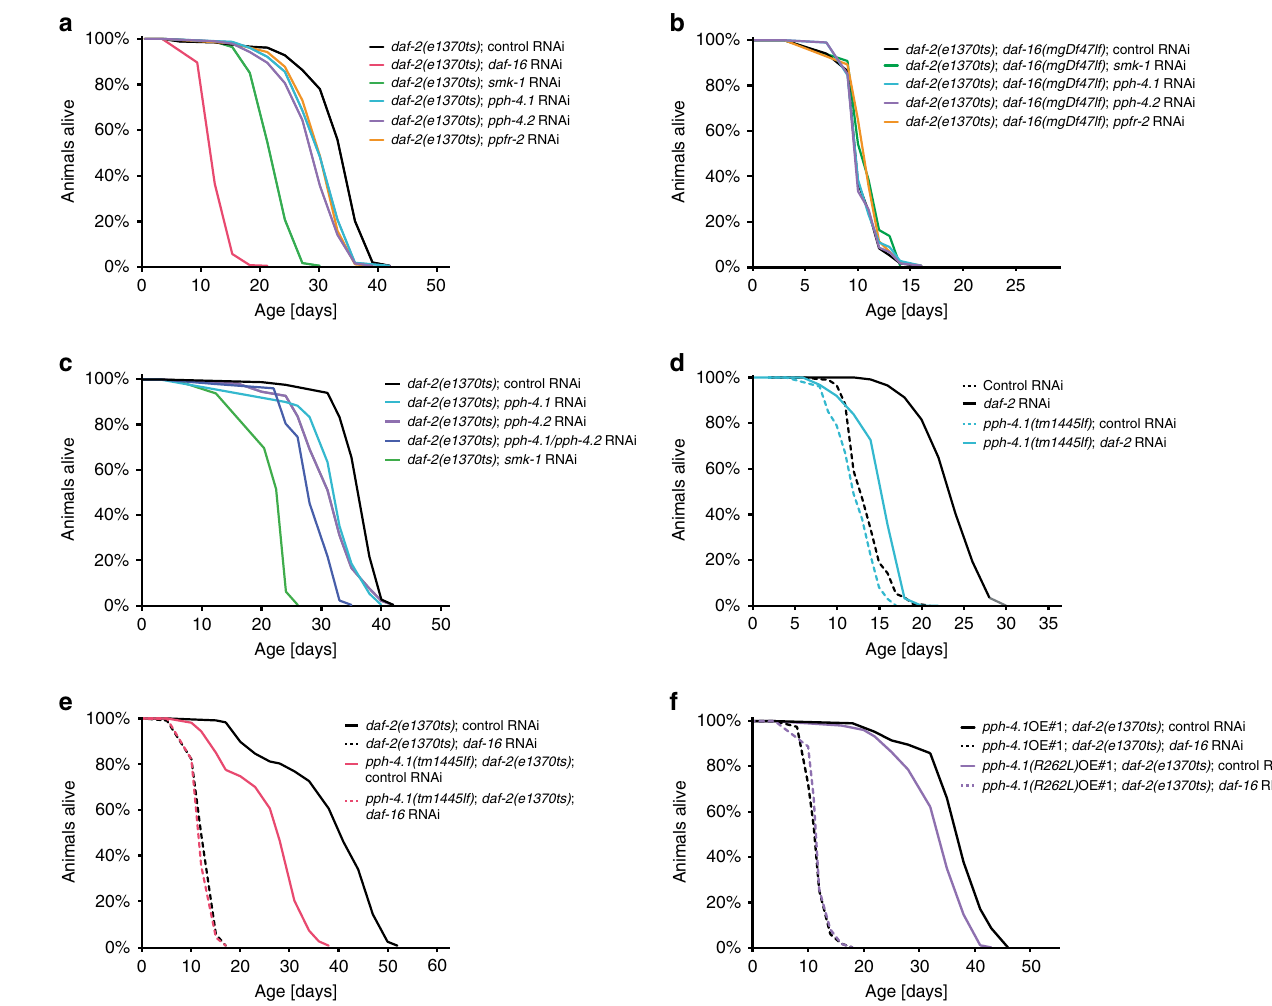
Fig. 2 SMK-1 promotes the DAF-16-mediated longevity induced by low IIS as part of PP4 SMK-1 . Lifespan phenotypes caused by loss of daf-16 or speci fi c PP4 subunits in various genetic backgrounds. Animals of indicated genotypes were grown from the L1 stage on the indicated RNAi bacteria at 15 °C. At the L4 stage the animals were shifted to 25 °C to fully inactivate daf-2(e1370ts) and their lifespan was monitored. All strains used in a – c harbored the eri-1 (mg366ts) mutation to yield better knockdown ef fi ciencies 51 . a Individual knockdown of daf-16 or any of the PP4 SMK-1 subunits shortened the lifespan of daf-2(e1370ts) mutant animals. b All these phenotypes were abolished in daf-16(mgDf47lf) null mutant animals. c Combined knockdown of the catalytic PP4 SMK-1 subunit paralogs pph-4.1 and pph-4.2 enhanced the lifespan-shortening effects of their individual knockdowns in daf-2(e1370ts) mutant animals. d , e The pph-4.1(tm1445lf) null mutation strongly impaired the longevity of low IIS animals in a daf-16 -dependent manner, too. f Lifespan analyses of daf-2 (e1370ts) mutant animals ectopically expressing either catalytically active PPH-4.1 or catalytic dead PPH-4.1(R262L). Expression of the catalytically dead PPH-4.1(R262L) speci fi cally impaired the longevity of daf-2(e1370ts) mutant animals. For detailed statistics see Supplementary Table 4. Source data are provided as a Source Data fi